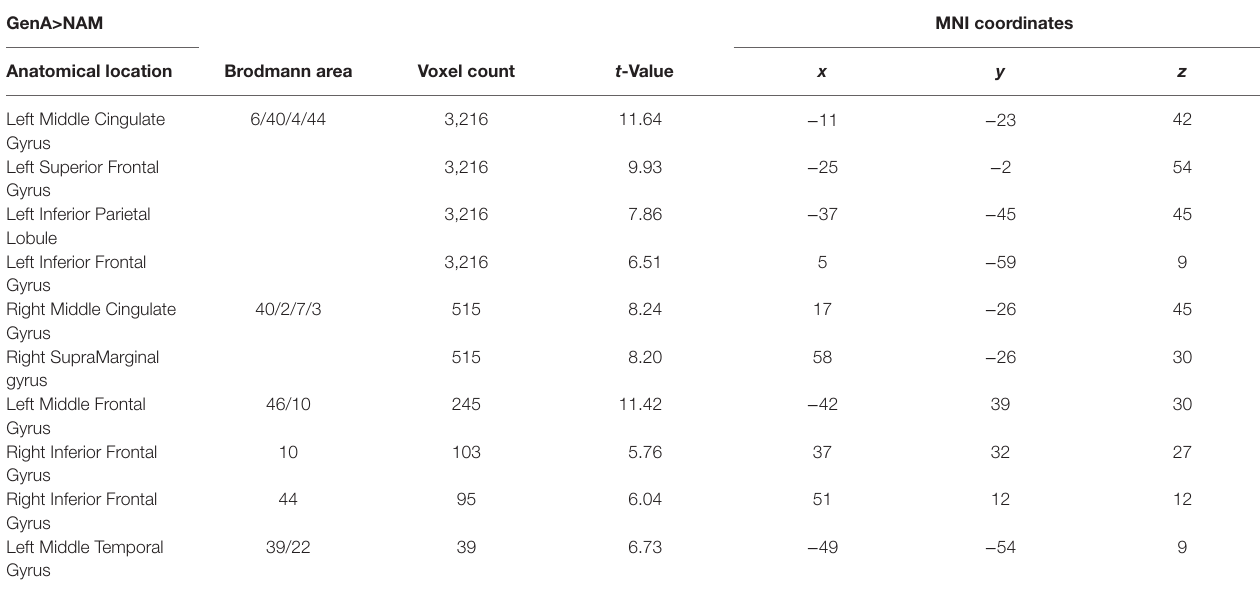
TABLE 1 | Activation peaks and extents for